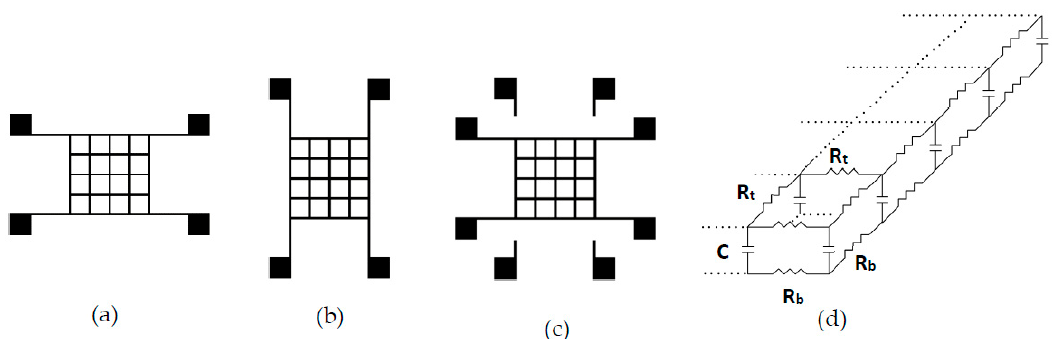
Figure 2. Illustrations of electrode patterns screen-printed on ( a ) top and ( b ) bottom sheets to produce sensor arrays, ( c ) tactile sensor produced by overlapped sensor arrays, and ( d ) equivalent circuit of the tactile sensor.